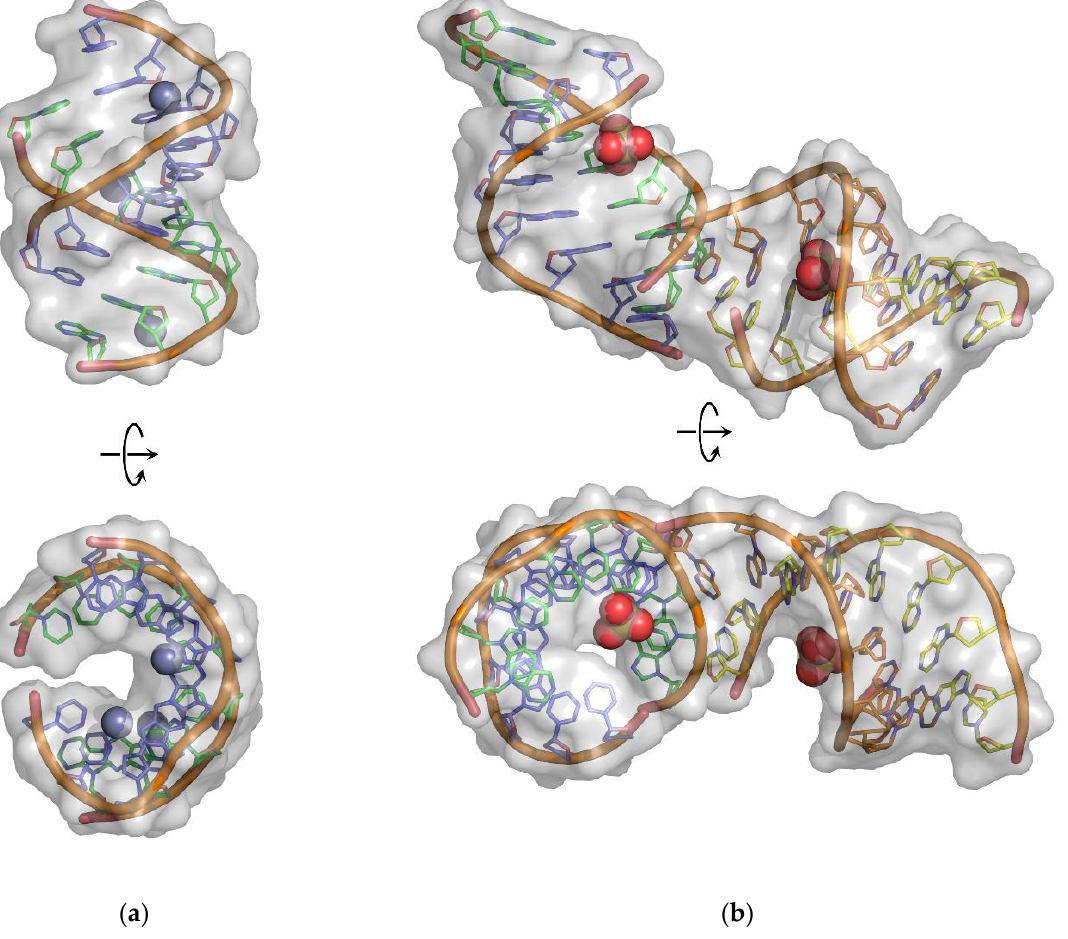
Figure 4 . Molecular structures of ( a ) overhanging and ( b ) blunt-ended DNA: 2′ -OMe-RNA du- Figure 4. Molecular structures of ( a ) overhanging and ( b ) blunt-ended DNA:2 (cid:48) -OMe-RNA duplexes. plexes. The DNA strands are colored as green and purple chains, whereas the 2′ -OMe-RNA The DNA strands are colored as green and purple chains, whereas the 2 (cid:48) -OMe-RNA strands are shown in the cyan and yellow color schemes. The positions of the Zn 2+ and SO 42 − ions are shown as